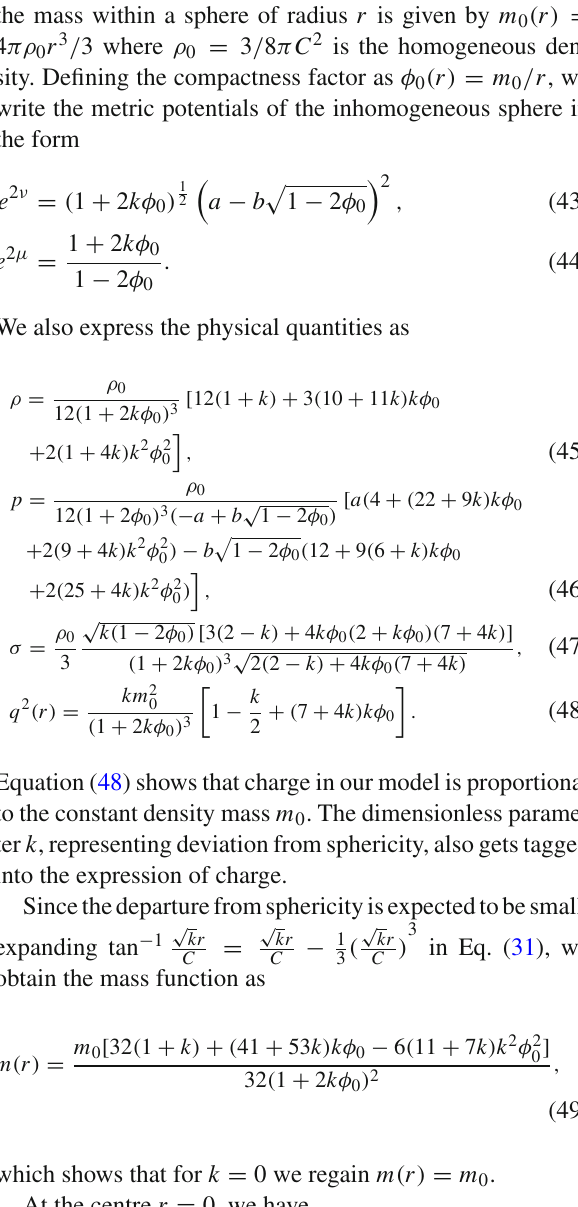
Table 2 Compactness M